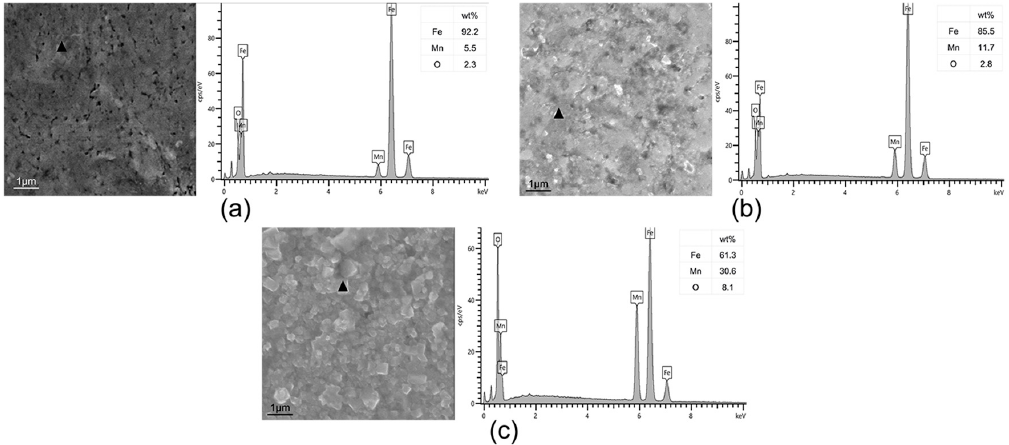
Figure 3. SEM micrographs and EDS analyses of surface oxides of samples annealed at different temperatures. ( a ) 1# (873 K), ( b ) 3# (923 K), ( c ) 5# (1093 K).